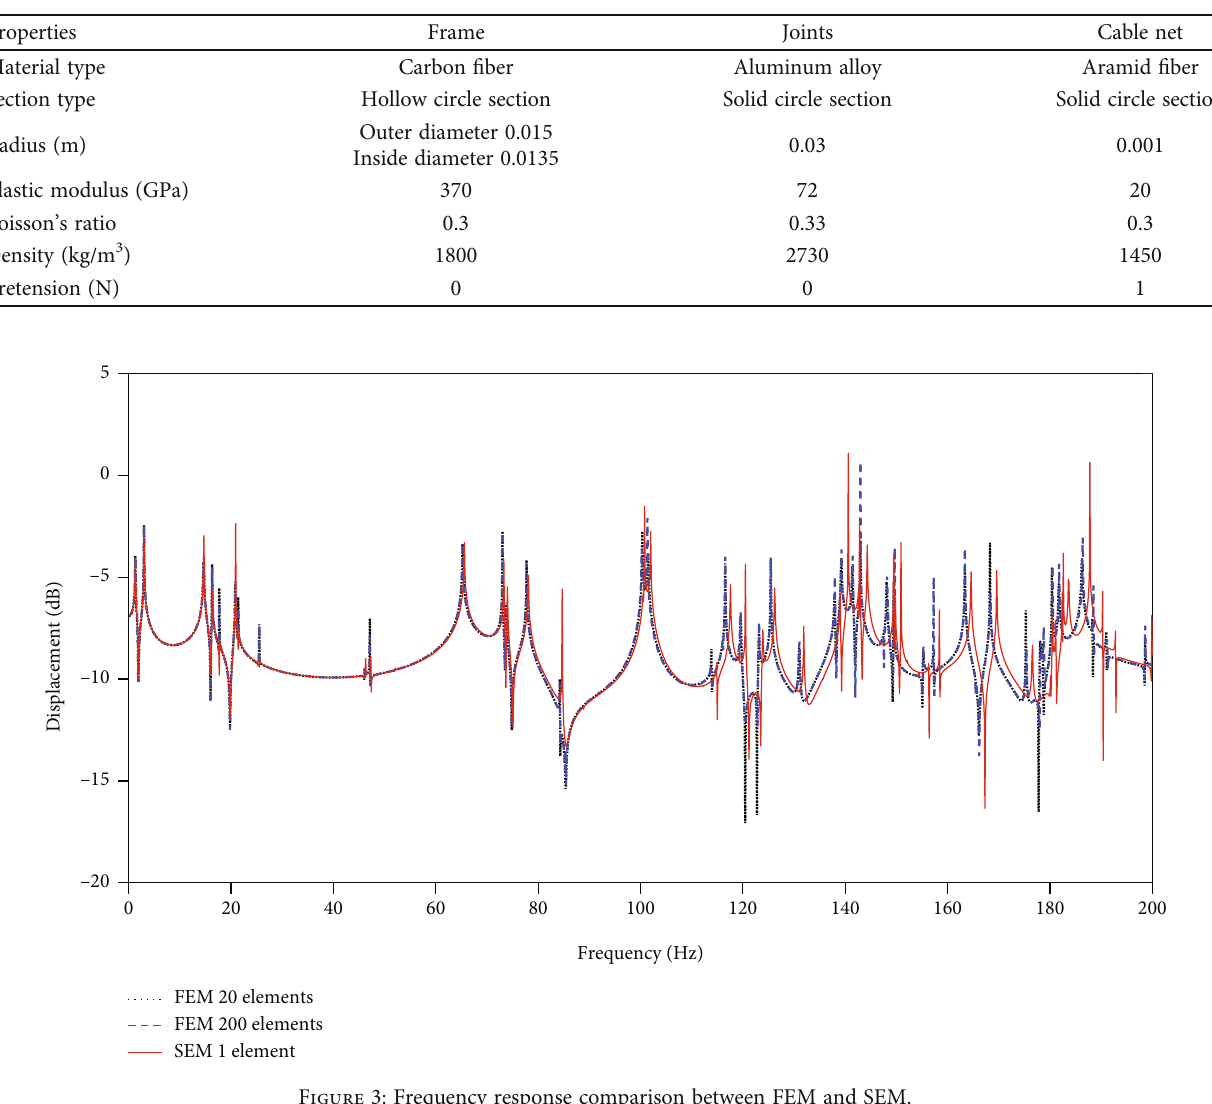
Figure 2: Equivalent super element. Table 1: Material parameters.